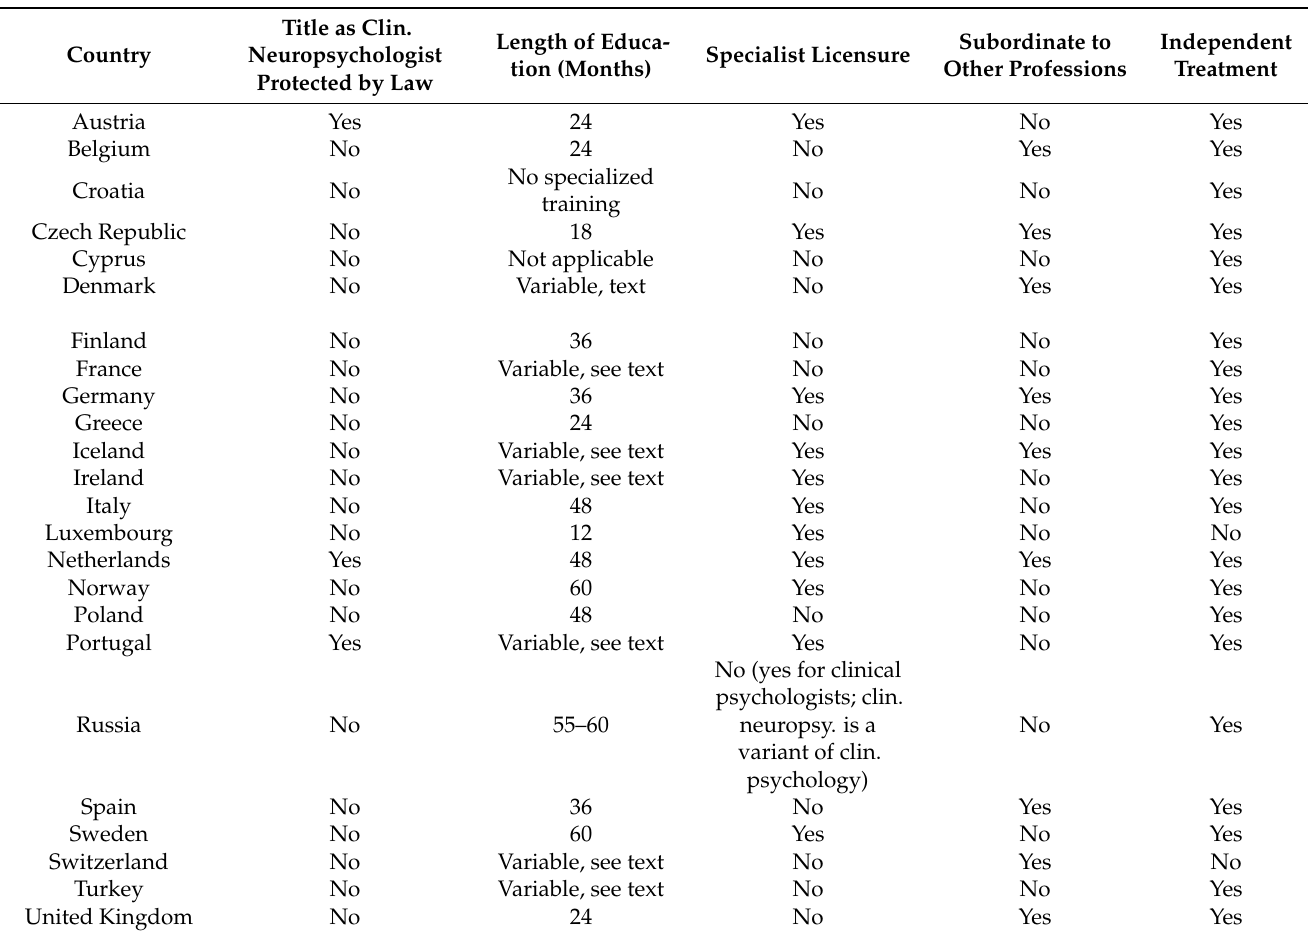
Table 2. Detailed information for the individual countries about whether a law or regulation protects the title of clinical neuropsychologist, the lengths of training in months (after bachelor and master), license as a specialist, subject to other professions and permission for independent